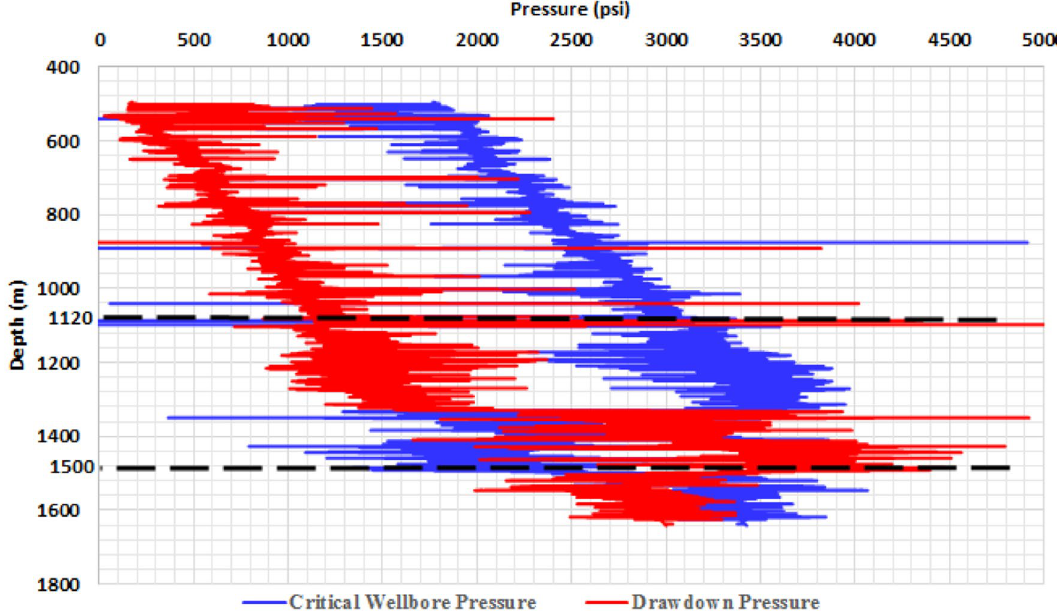
Fig. 19 Critical wellbore pressure and drawdown pressure of Field